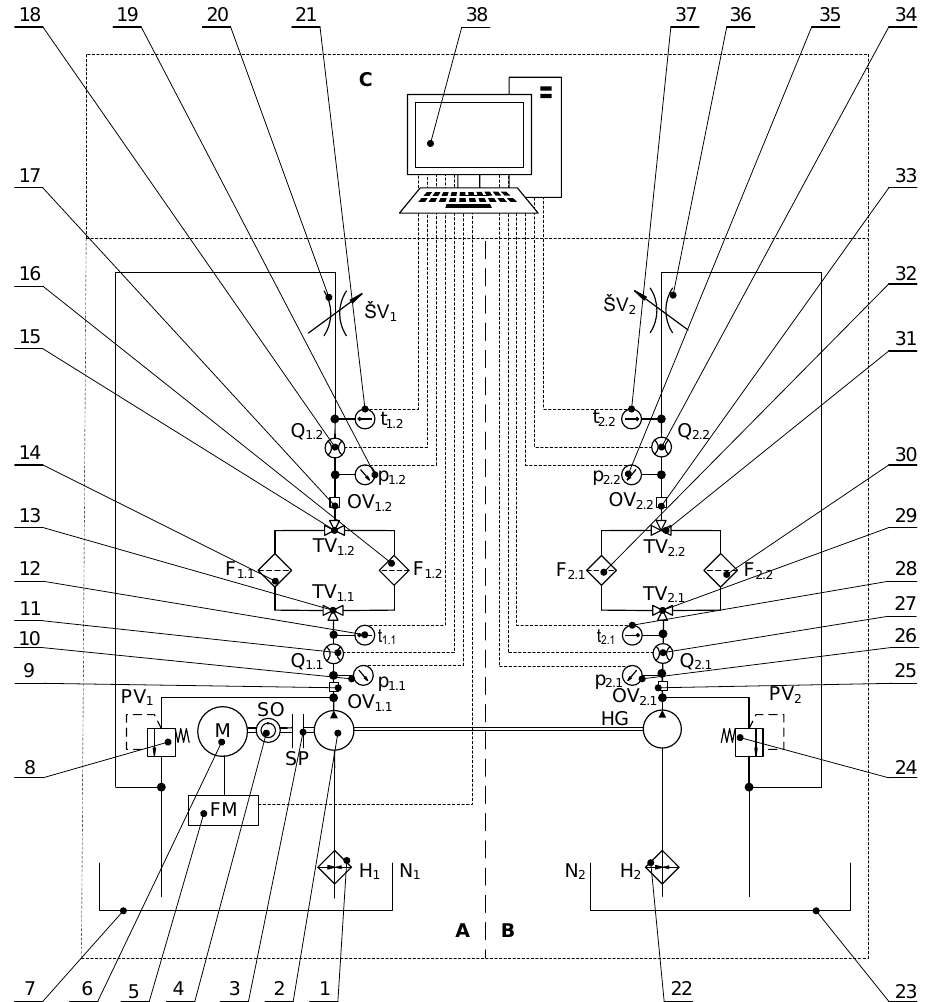
Figure 3. Equipment for comparing the flow properties of oil filter materials in the lubrication circuits of internal combustion engines. Legend: A —reference measuring circuit; B —test measuring circuit; C —recording and evaluation circuit; 1, 22— heaters; 2—tandem hydraulic pump; 3—coupler; 4—rpm sensor; 5—frequency converter; 6—electric motor, 7, 23—tanks; 8, 24—safety valves; 10, 19, 26, 35—pressure sensors; 11, 18, 27, 34—flow sensors; 12, 21, 28, 37—temperature sensors; 13,